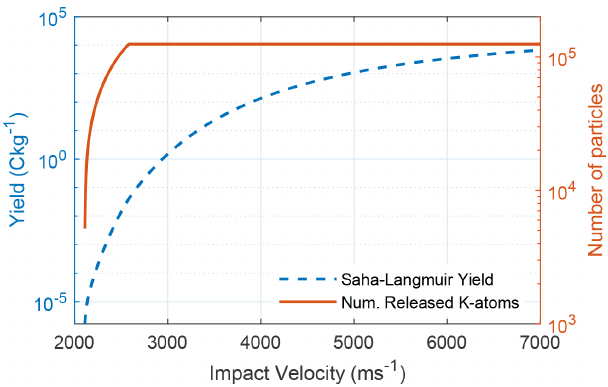
Figure 8. Results from calculation of impurity (1% potassium) charging using the Saha–Langmuir equation (blue, dashed) and fragmentation model described in this work. The solid red line shows the number of released K atoms as a function of velocity and therefore constitutes a theoretical upper bound on the charge number (for singly charged